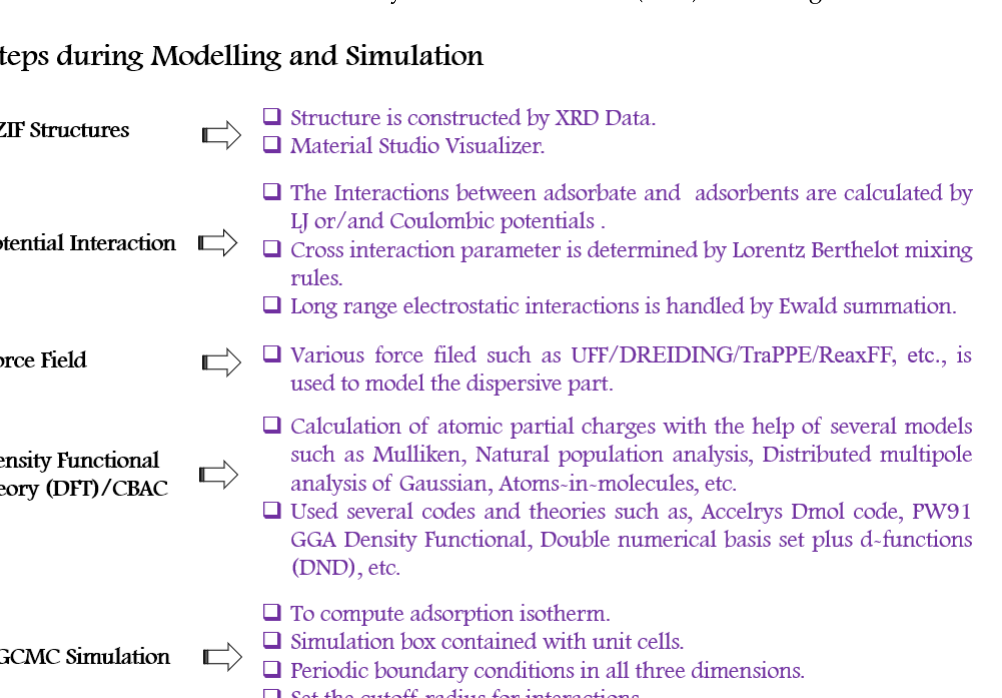
Non-Bonded Interactions 1.